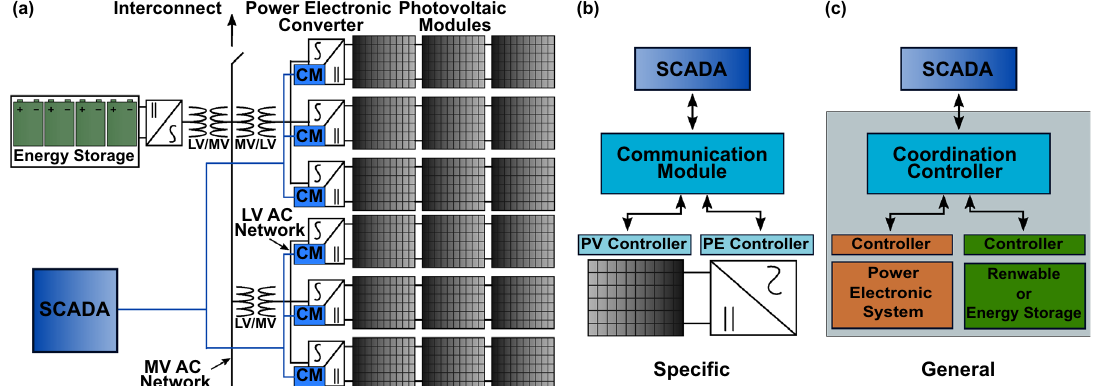
Figure 1. ( a ) Example of photovoltaic plant construction with voltage collector system (black) and communications network (blue). Architecture concept for ( b ) Specific and ( c ) General communications and